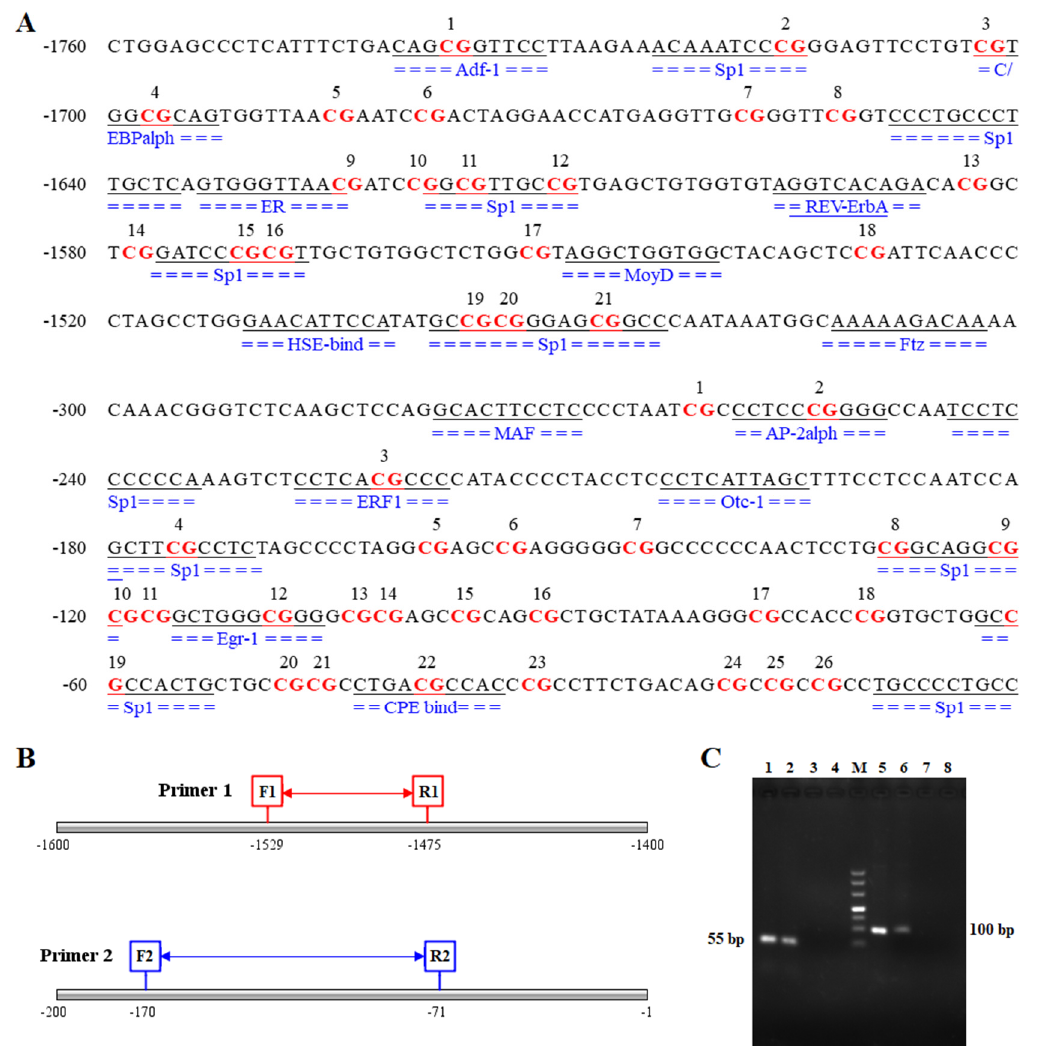
Figure 5. Analysis of the transcription factor binding domain near the CpG island and the result of Chromatin Co-Immunoprecipitation (ChIP)-PCR analysis. ( A ): Sites of transcription factor binding regions near the CpG islands in the porcine AQP3 gene; ( B ): Sequence position of the fragment targeted by the two pairs of ChIP-PCR primers; ( C ): ChIP-PCR, lanes 1–4 and 5–8 are two di ff erent groups representing the PCR products of primer1 and primer2: Input, IP, IgG, and water, M represents the DL500 marker.